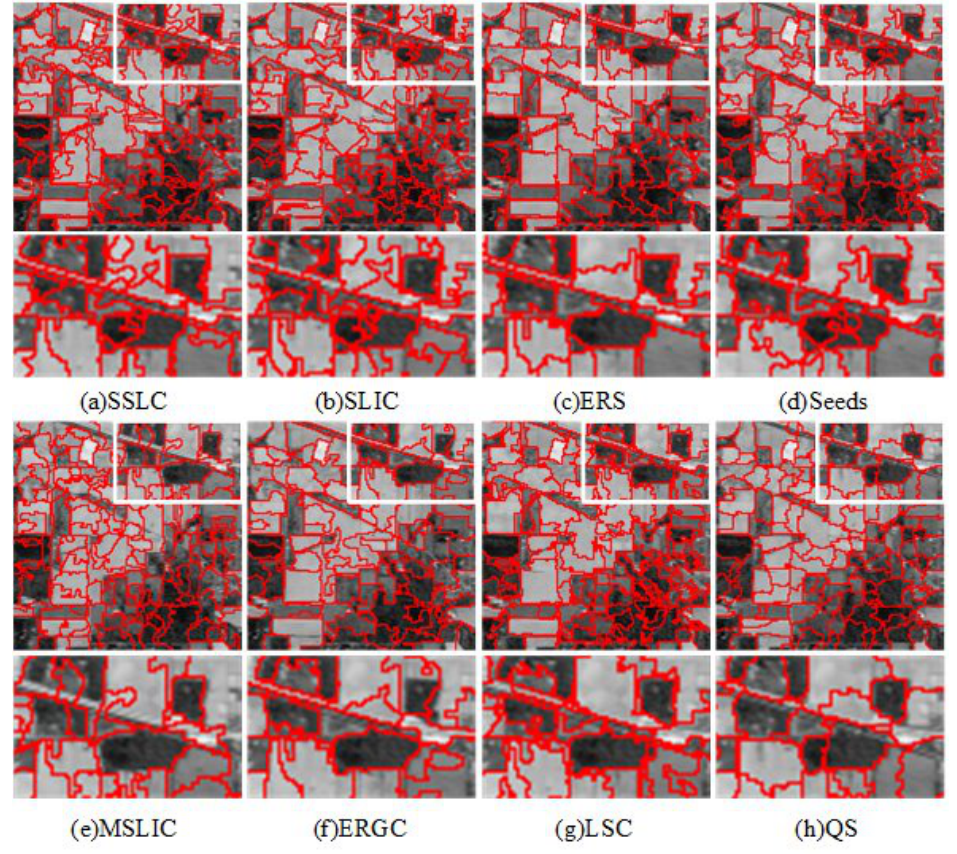
Figure 14. The first and third rows are superpixel segmentations of AVIRIS image Indian Pines provided by ( a ) SSLC; ( b ) SLIC; ( c ) ERS; ( d ) Seeds; ( e ) MSLC; ( f ) ERGC; ( g ) LSC; and ( h ) QS. The second and fourth rows zoom in on the regions of interest as defined by the white boxes to facilitate close visual inspection.